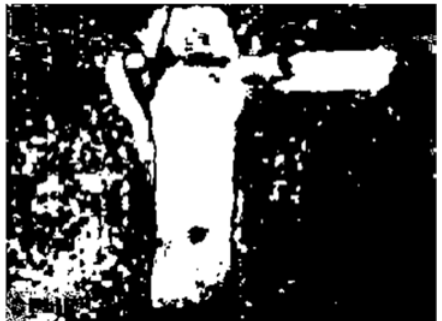
Figure 11. Binary image (0.1 < | hag ‐ ag1b| < 1) of difference: | hag ‐ ag1b| .